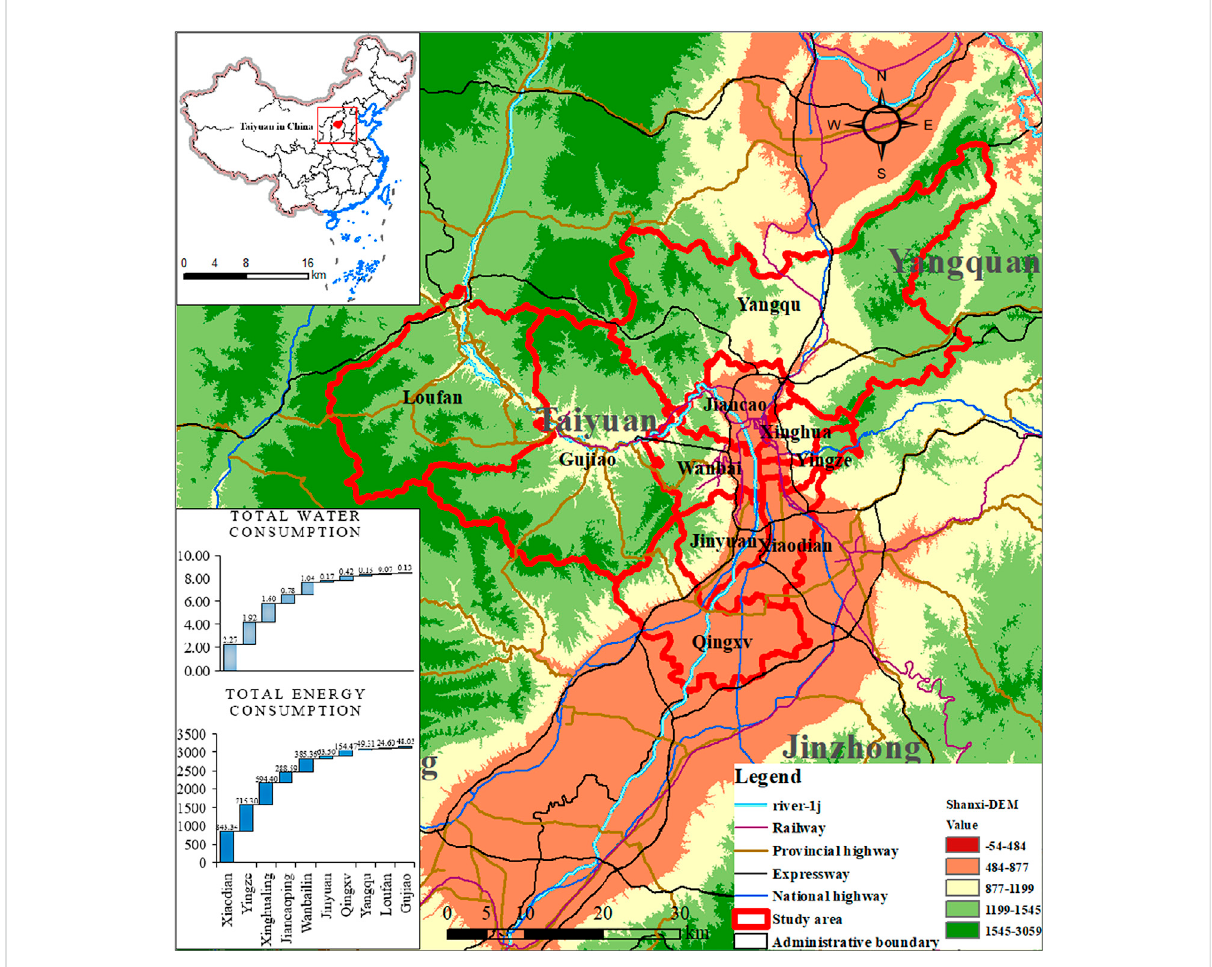
FIGURE 1 Location of study region in China (The unit of total water consumption is 100 million cubic meters, The unit of total energy consumption is 10,000 tons of standard coal, the unit of DEM base map is meter, and the unit of scale is